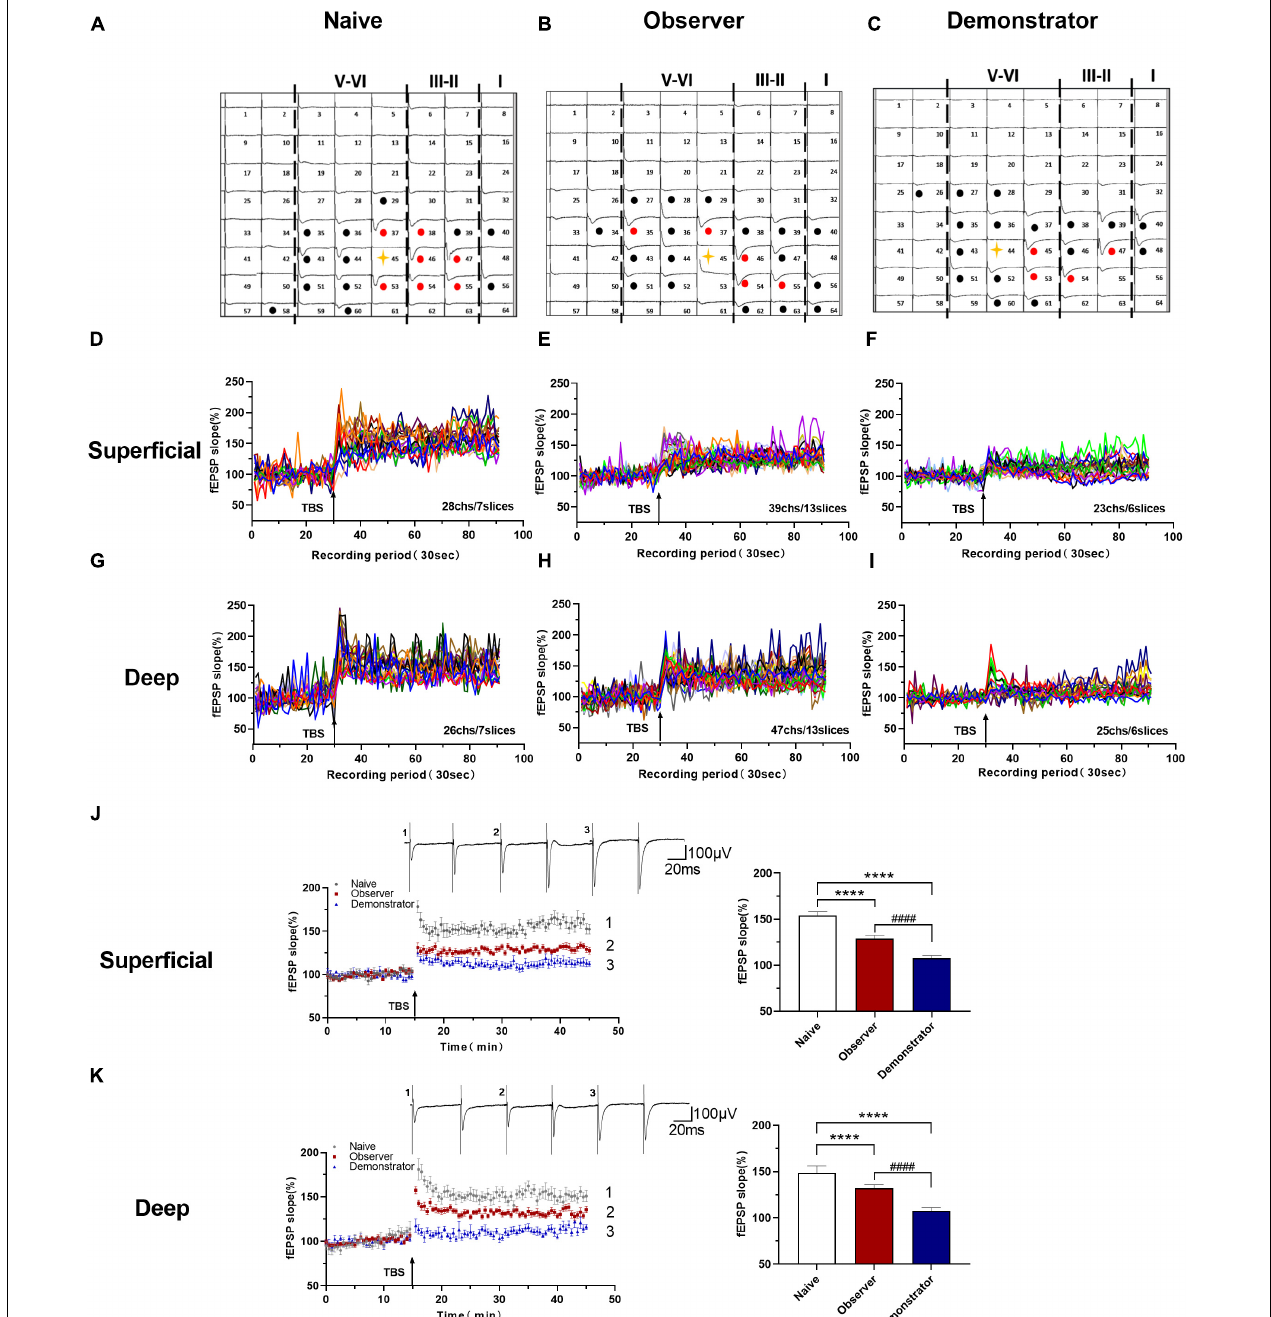
FIGURE 3 | Time course LTP in the aIC of observer and demonstrator mice. (A–C) Samples of an overview of multisite synaptic responses recorded at baseline (black) and showing LTP after TBS (red) in naïve (A) , observer (B) , and demonstrator mice (C) , respectively. The flash denotes the stimulated channel, red- and black-filled circles mark all activated channels, vertical lines demarcate different layers; (D–I) All channels with LTP of naïve, observer, and demonstrator mice. (D) 28 channels of 7 slices with LTP in the superficial layers of aIC in naïve mice. (E) 39 channels of 13 slices with LTP in the superficial layers of aIC in observer mice. (F) 23 channels of 6 slices with LTP in the superficial layers of aIC in demonstrator mice. (G) 26 channels of 7 slices with LTP in the deep layers of aIC in naïve mice. (H) 47 channels of 13 slices with LTP in the deep layers of aIC in observer mice. (I) 25 channels of 6 slices with LTP in the deep layers of aIC in demonstrator mice; (J,K) Left: Time course of averaged fEPSP slope of all active channels from the superficial (J) and deep layers (K) of aIC in naïve, observer, and demonstrator mice. The arrow indicates the time of TBS application in the deep layer V/VI. Right: the average slope and of all active channels within the last 10 min recording in the superficial (J) and deep layers (K) of aIC; Data are shown as mean ± SEM (Naïve n = 7 slices of 6 mice, observer n = 13 slices of 9 mice, and demonstrator n = 6 slices of 6 mice) and compared by unpaired t -test, **** p < 0.0001, vs. naïve; #### p < 0.0001, observer vs. demonstrator.